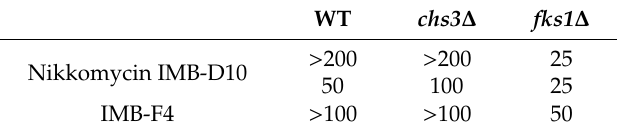
Table 2. The synergetic e ff ect of compounds IMB-D10 and IMB-F4 with caspofungin against S. cerevisiae. Compound MIC ( µ g / mL) MIC of Caspofungin ( µ g / mL) FICI Alone Combination Combination Nikkomycin > 100 12.5 0.0075 < 0.5 IMB-D10 50 12.5 0.0075 0.5 IMB-F4 > 100 25 0.0075 < 0.5 Caspofungin 0.03 - - - MIC is the minimum inhibitory